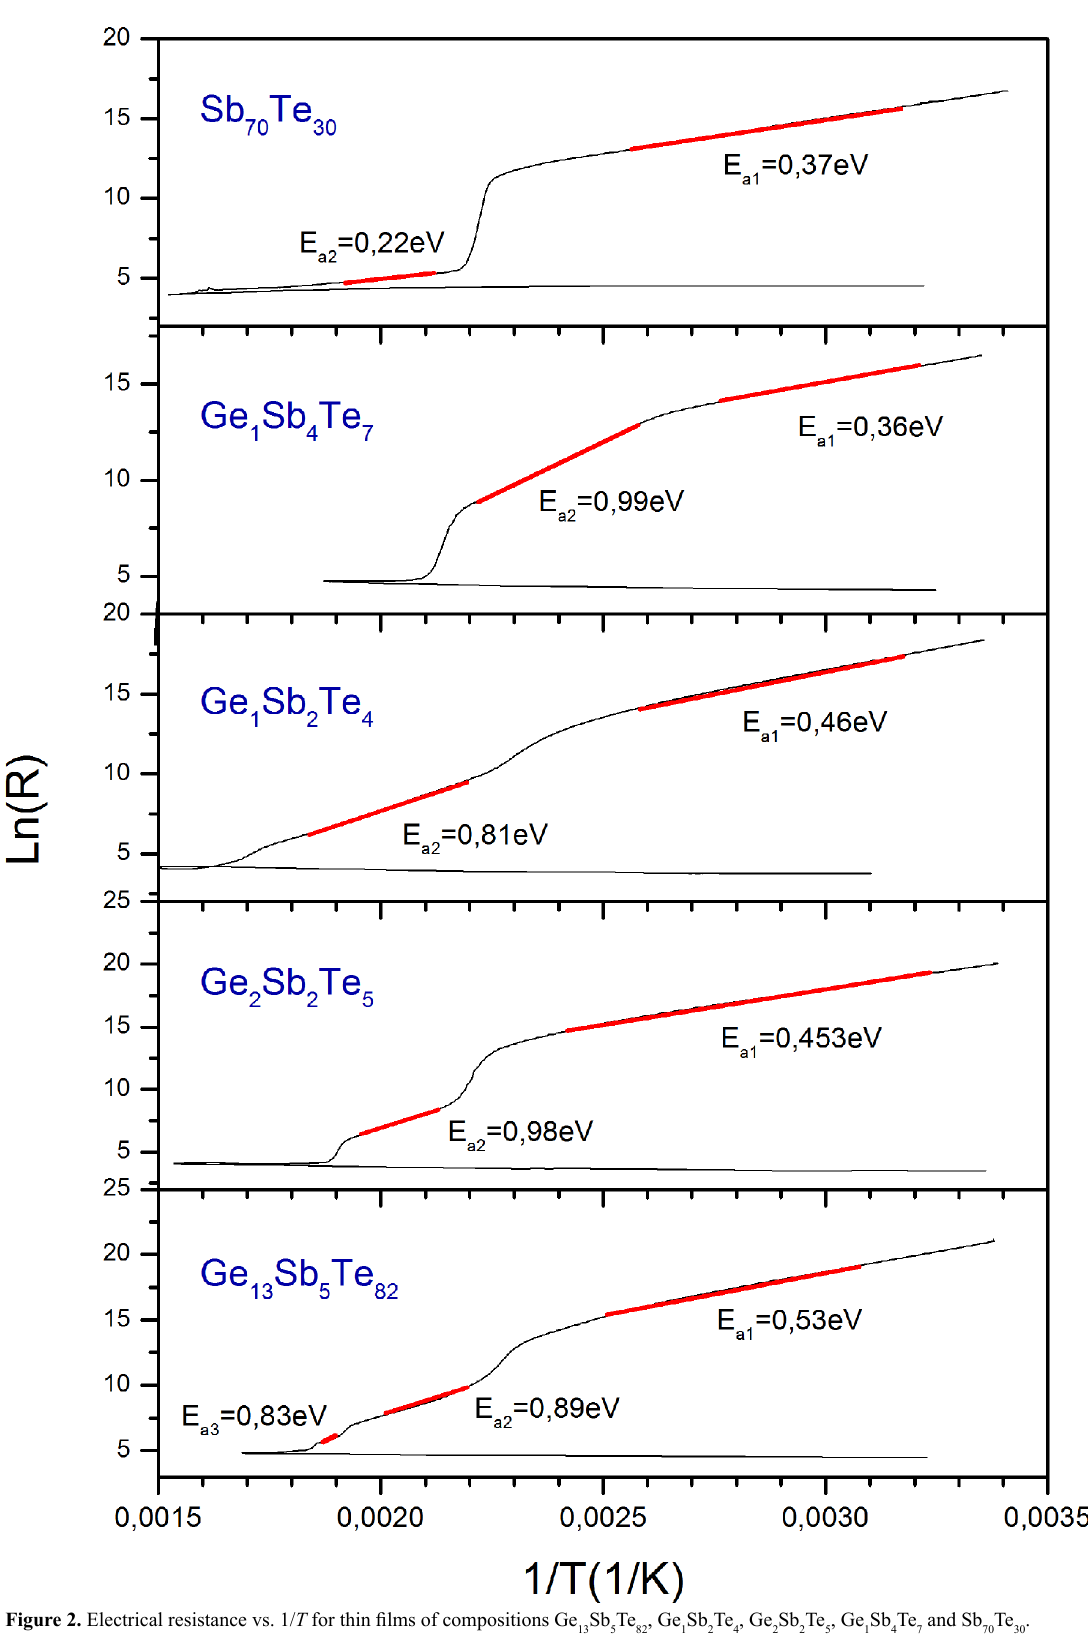
Figure 2. Electrical resistance vs. 1/ T for thin films of compositions Ge